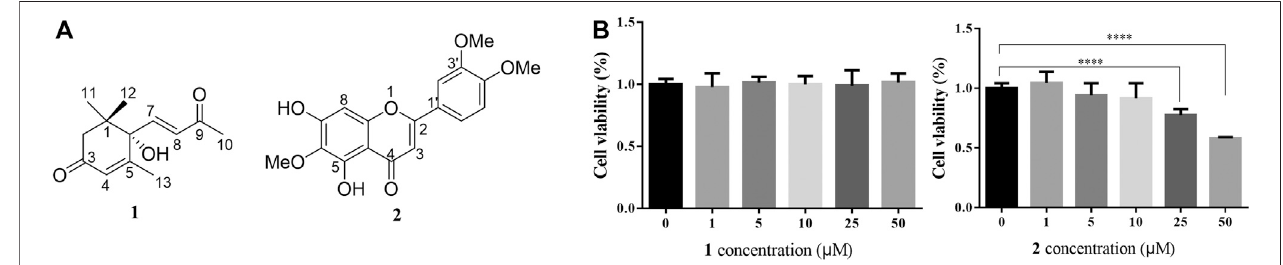
FIGURE 1 | Chemical structures of 1 and 2 , and their cytotoxicity analysis. (A) Chemical structures of compounds 1 and 2 isolated from the methylene dichloride (CH